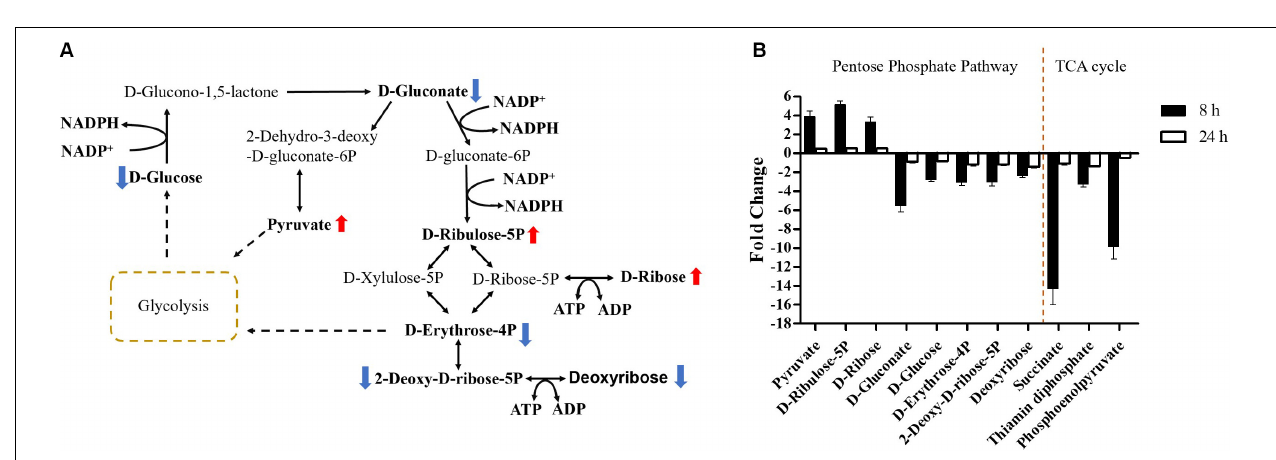
FIGURE 6 | Perturbations of lipids and related metabolites. Enrichment analysis (A,B) and pathway analysis of significantly altered metabolites (C,D) in E. coli TOP10 with over-expression of mcr-1 at 8 and 24 h, respectively. FDR < 0.05, p < 0.05 and fold change ≥ 2, one-way ANOVA. The pathway enrichment analysis was based on KEGG Pathway with reference to E. coli K-12. The figures were produced by MetaboAnalyst 4.0 (https://www.metaboanalyst.ca/).